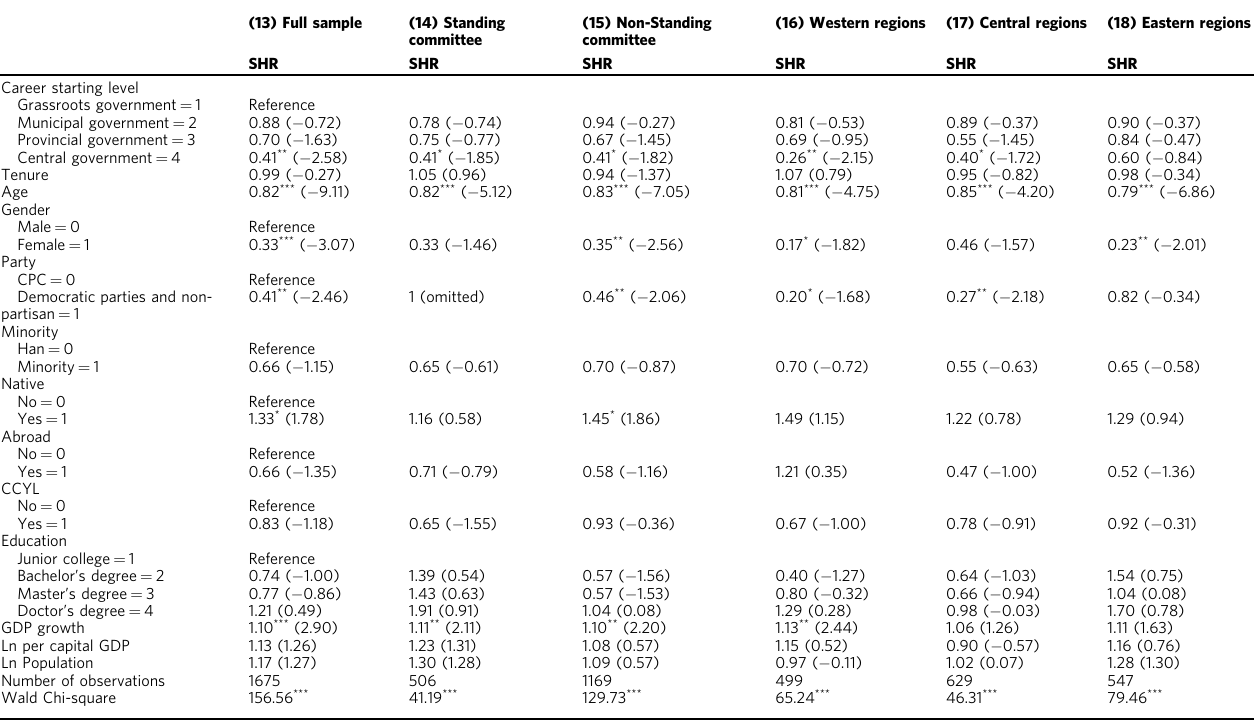
Table 4 The competing risk regression results estimating the effect of different career starting levels on political